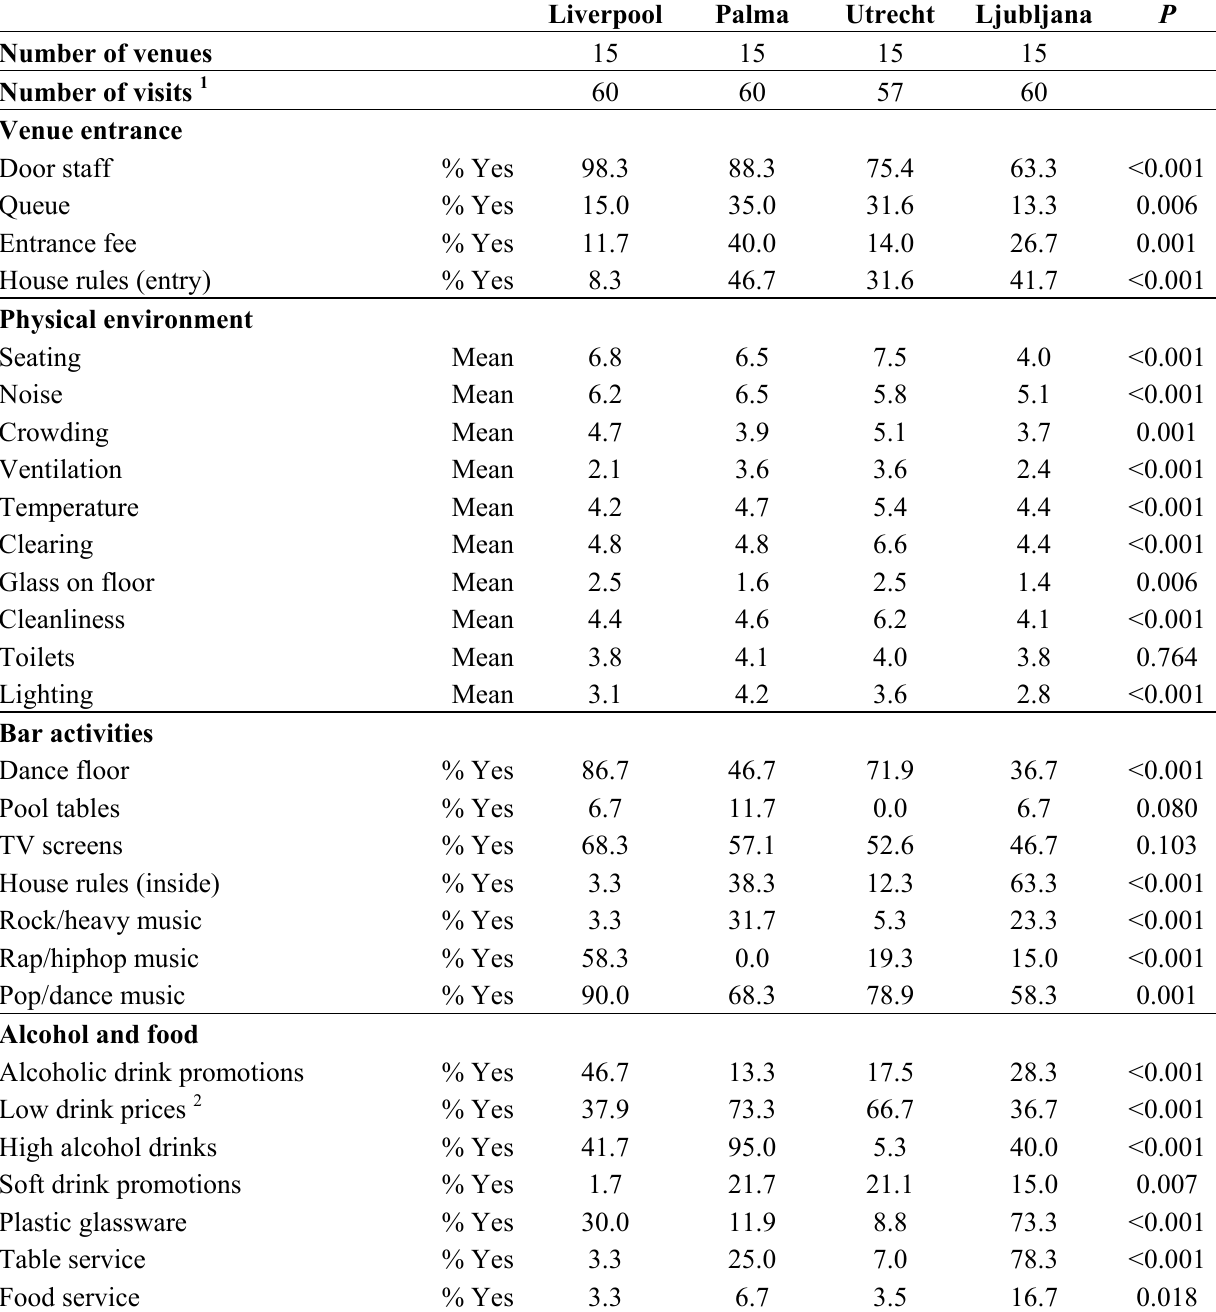
Table 1. Proportion of observations displaying environmental characteristics, and mean scale ratings for environmental measures, by city of